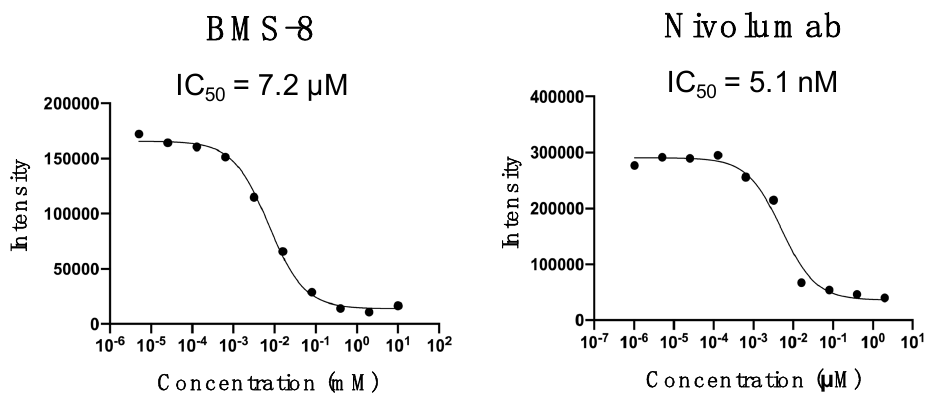
Figure 2. Inhibition of PD-1 / PD-L1 interaction by BMS-8 and nivolumab measured by the AlphaLISA ® assay.